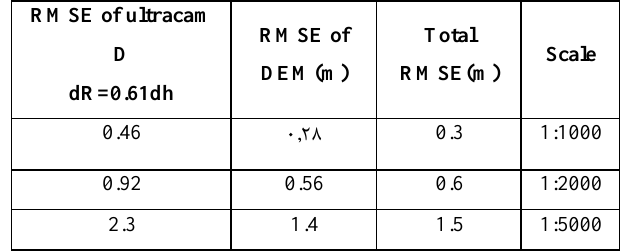
Table1. Amount of permissible DEM height error in